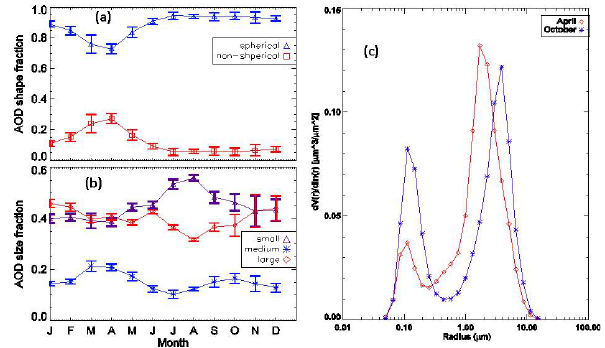
Fig. 9. (a) Climatology of AOD shape fractions from MISR (2001– 2008) at 558nm (green band) over Nile Delta and (b) AOD size aerosol fractions at 558nm (green band) over the Nile Delta for eight years (2001–2008). (c) is size distribution of AERONET sta- tion at Cairo on April 2005 (red color), and October 2005 (blue